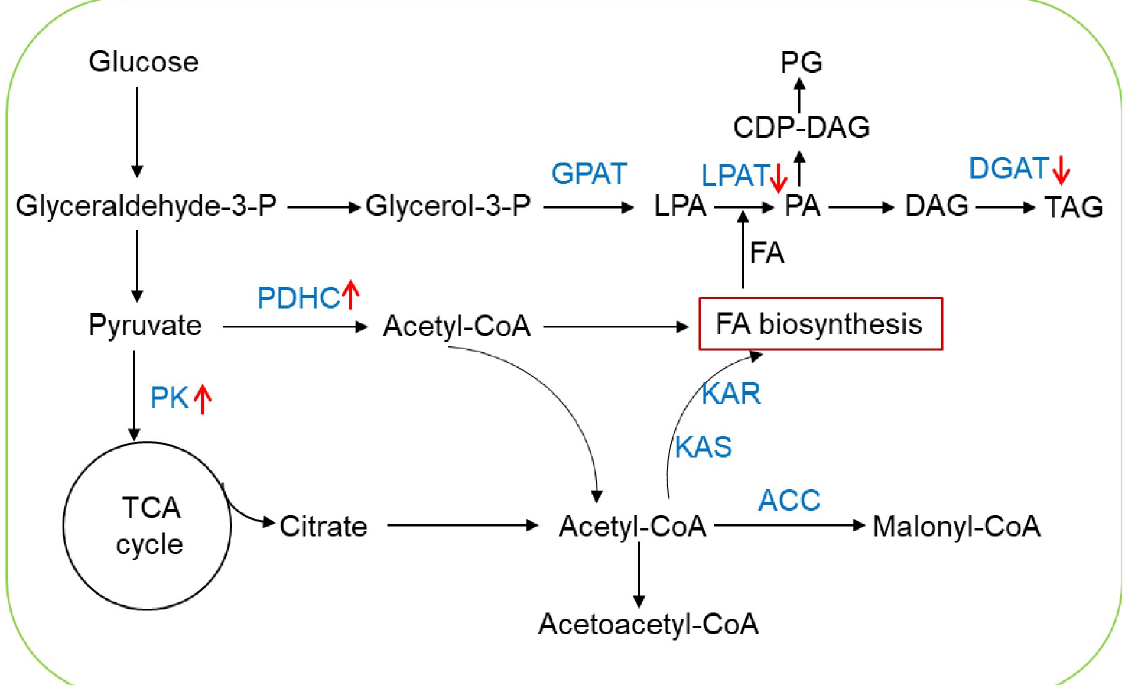
Fig 7. Differential expression analysis of genes related to lipid metabolism under ND in P . cruentum . The pathway of lipid metabolism was briefly constructed and the transcriptional change of sever unigenes was presented with arrow of “ " ” and “ # ” represented upregulation and downregulation under ND,